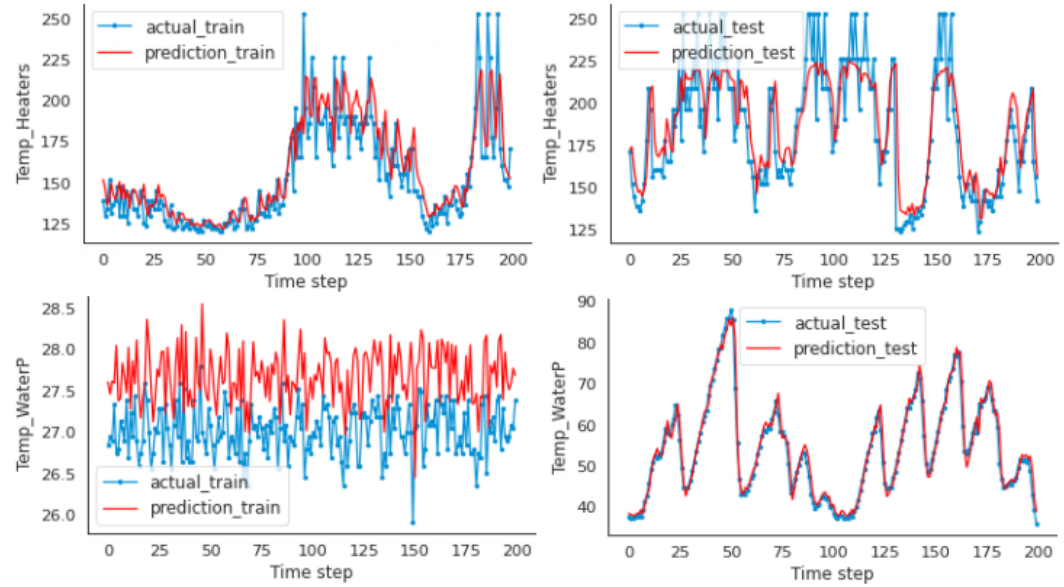
Figure 15. Actual and predicted results for heaters and pumps models.